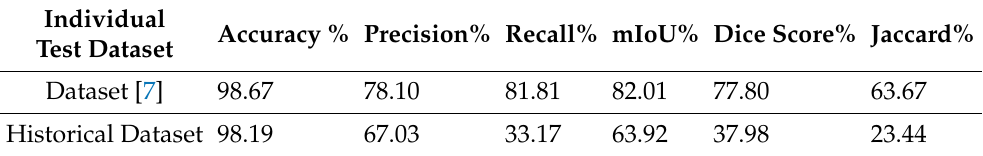
Table 4. Results of ResU-Net++-based crack segmentation on individual datasets (no contrast stretching).